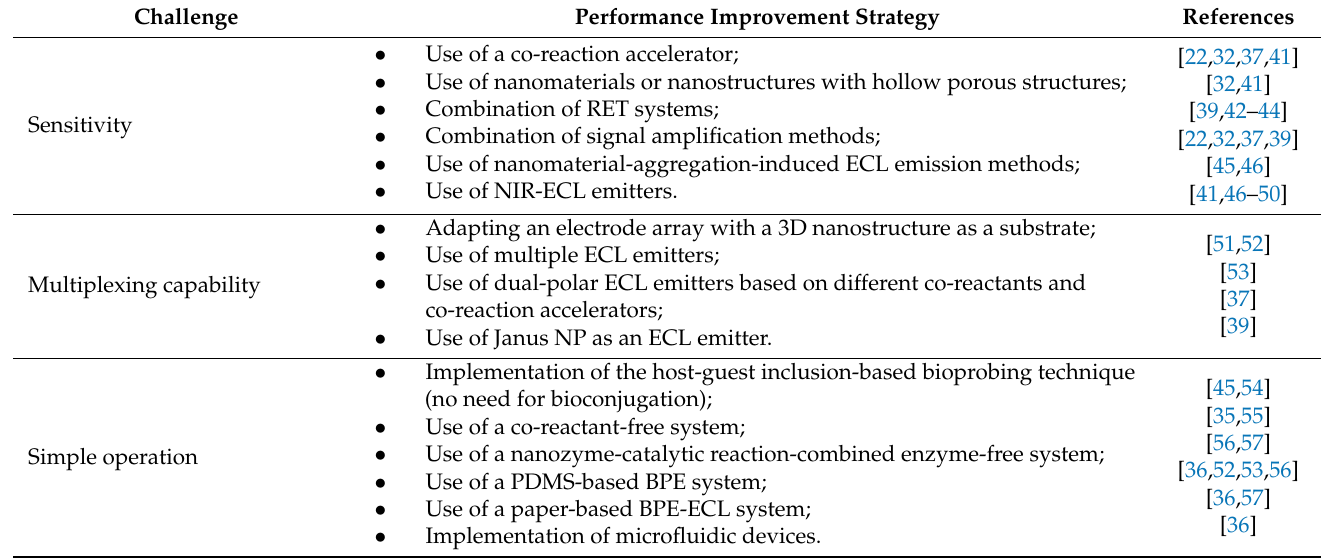
Table 3. Challenges and strategies for improving the performance of the biomarker detection ECL